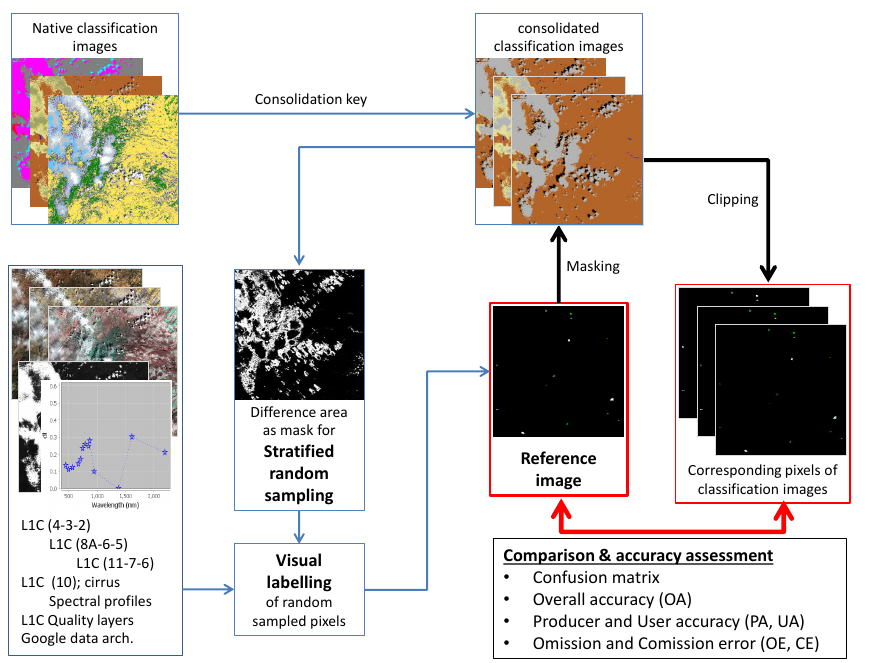
Figure 2. Schema for classification reference mask generation on example of Sen2Cor scene classifica- tion (SCL) product over Barrax test-site (Spain), acquired on 19 May 2017. This example represents various topography (flat and rough) and land-cover (vegetated, nonvegetated, water) as well as cloud cover dominated by the cumulus clouds. Process starting in left part with L1C channel combinations, continuing with the consolidation, stratified random sampling and visual labeling to create the reference image. Red circled image cubes: zoomed